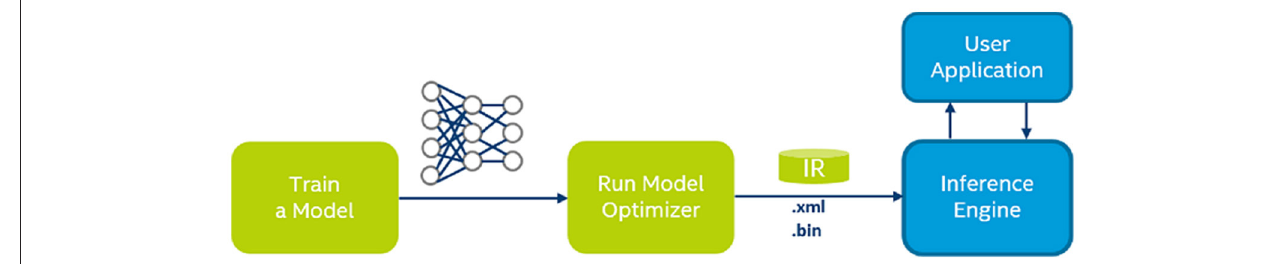
FIGURE 2 | Network training and deployment on Neural Compute Stick 2 (NCS2).